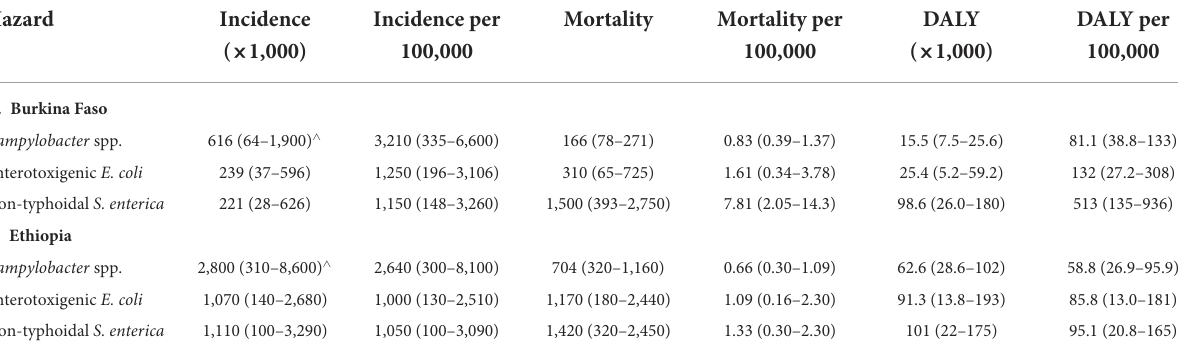
TABLE 4 Foodborne disease burden for three bacterial hazards in Burkina Faso and Ethiopia in 2017 (all ages) according to WHO FERG (Havelaar et al., 2015), updated according to the Global Burden of Disease study (Kyu et al., 2018).